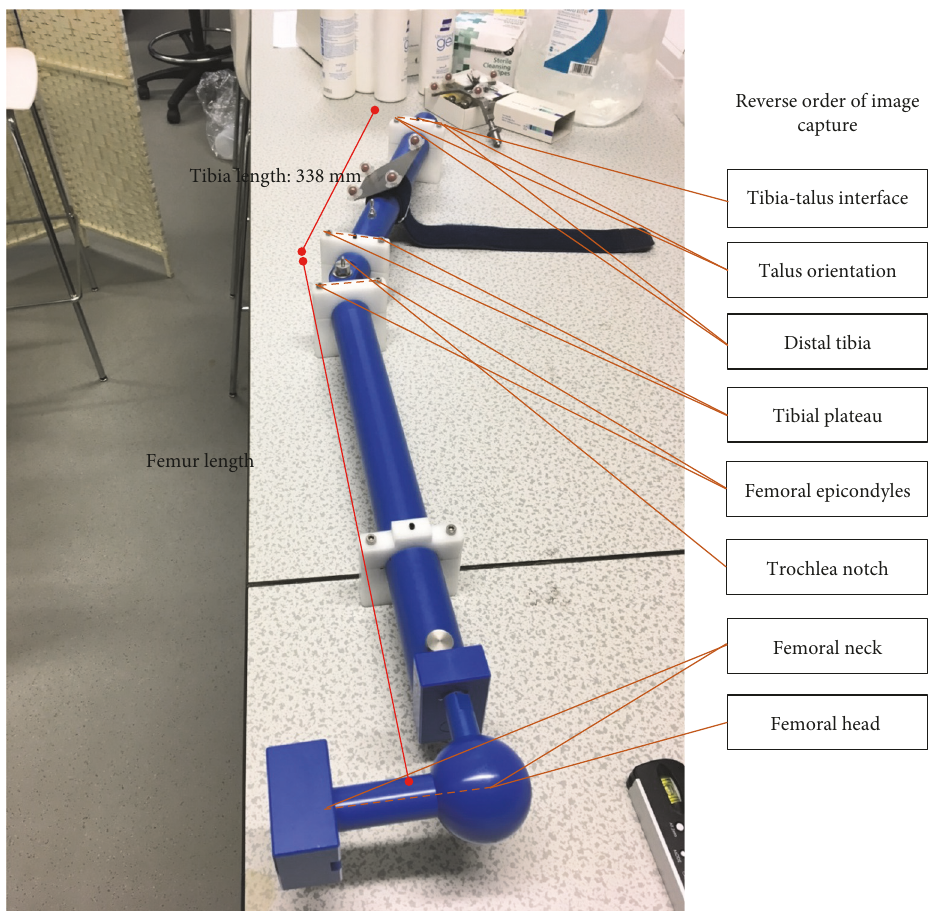
Figure 2: Landmarks needed for full analysis of the phantom, shown at 23 ° varus for a “ left ” leg.